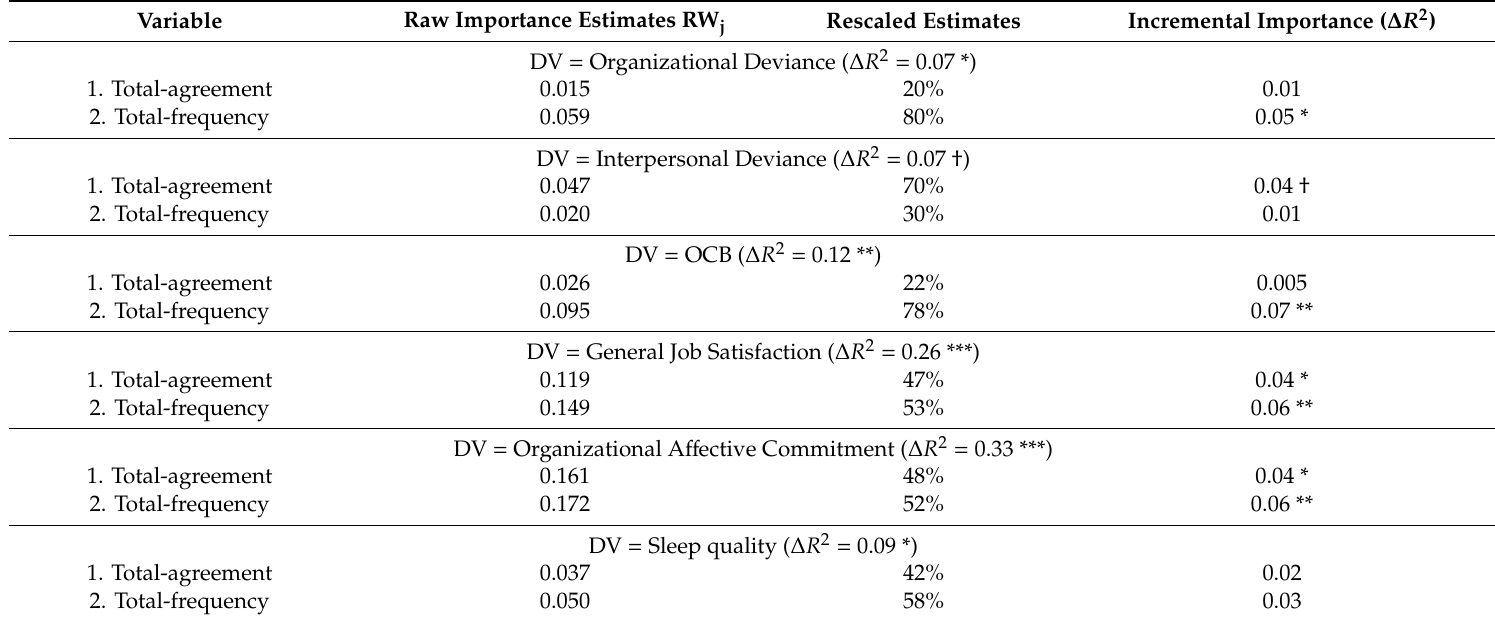
Table 4. Relative importance analysis for Sample 1 ( N =